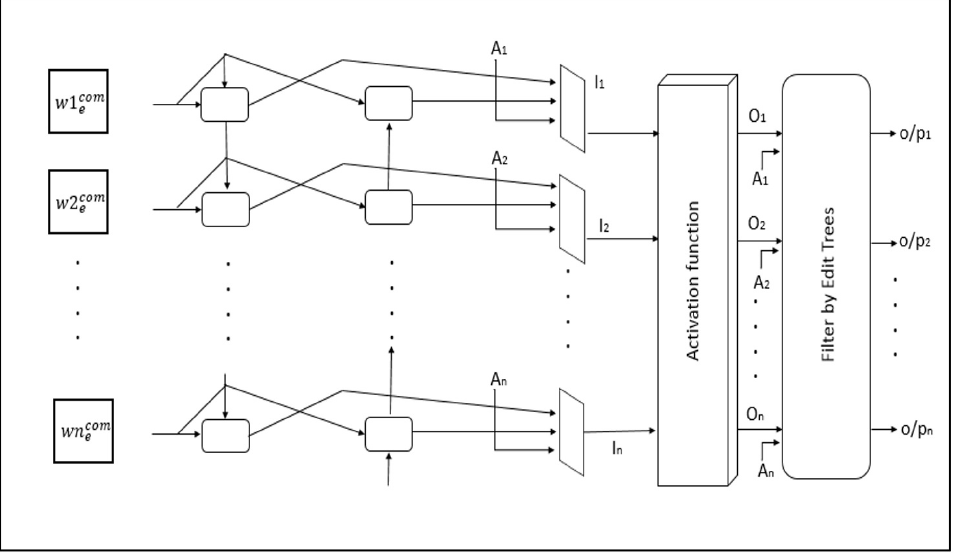
Figure 5. Second-level bidirectional gated neural network model (BiGRNN, BiLSTM, and